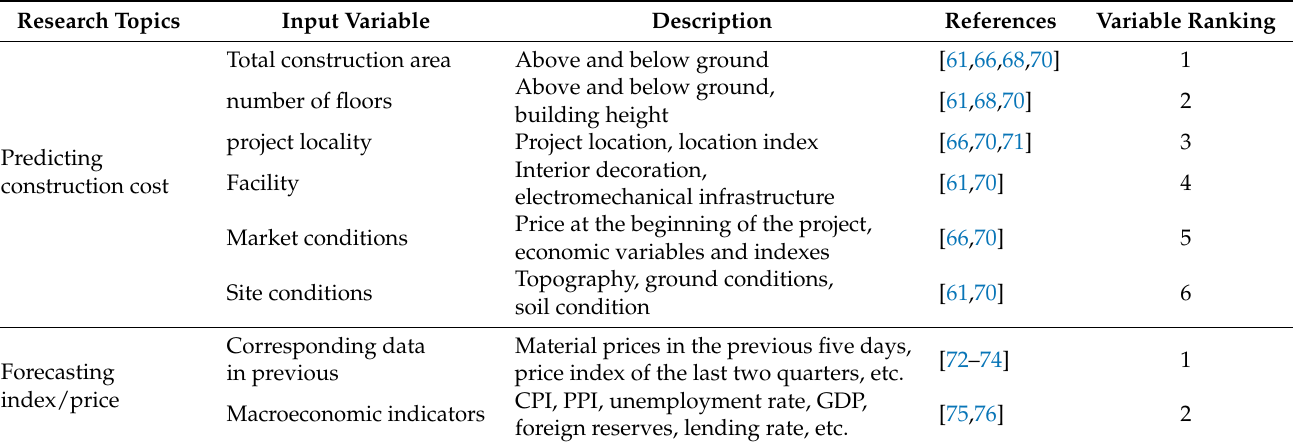
Table 5. Important variables in main cost